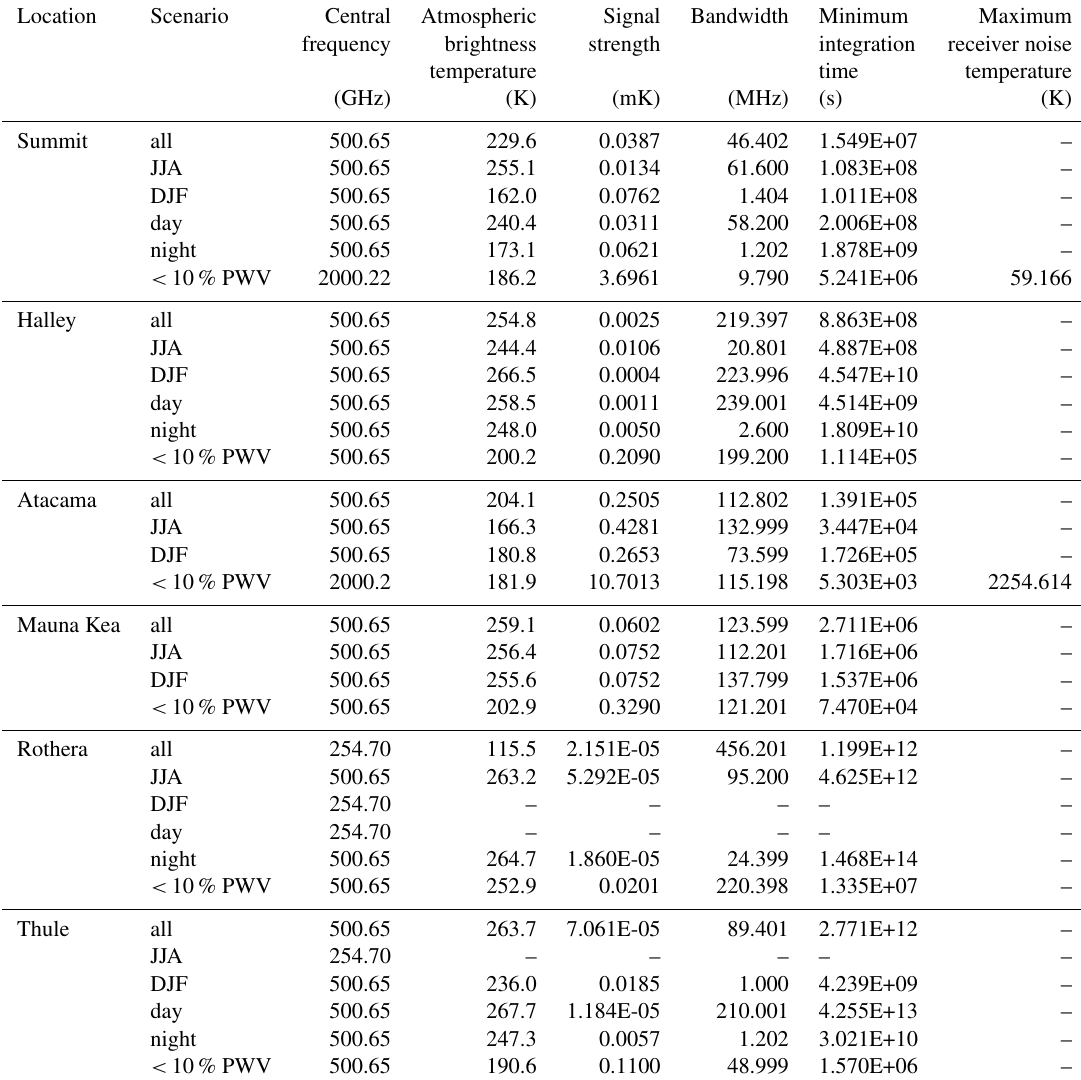
Table 5. Characteristics of bands selected based on the strongest signal at each location and scenario for HBr. Minimum integration times, τ , and maximum receiver noise temperatures, T rcr , are calculated from Eq. (3). The T rcr used to calculate τ is given by the appropriate ALMA band in Table 4). τ is specified as 30min when calculating T rcr . The signal-to-noise ratio is 2. A dash indicates that the signal is below this